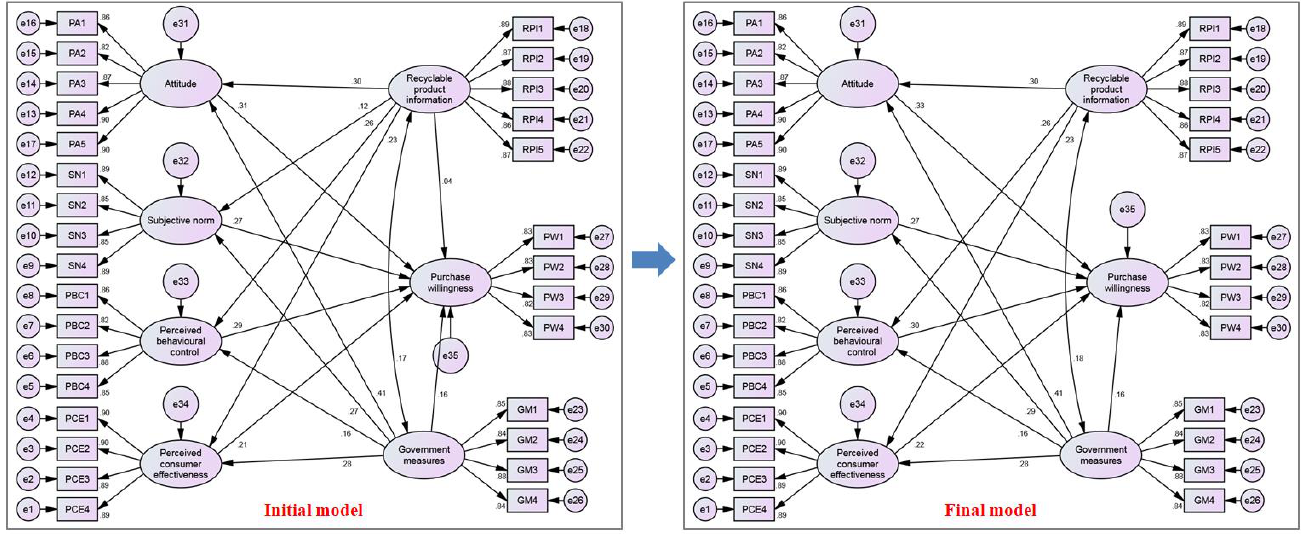
Figure 4. Standardized estimation of the initial and final models. Table 5. Goodness-of-fit of the model.